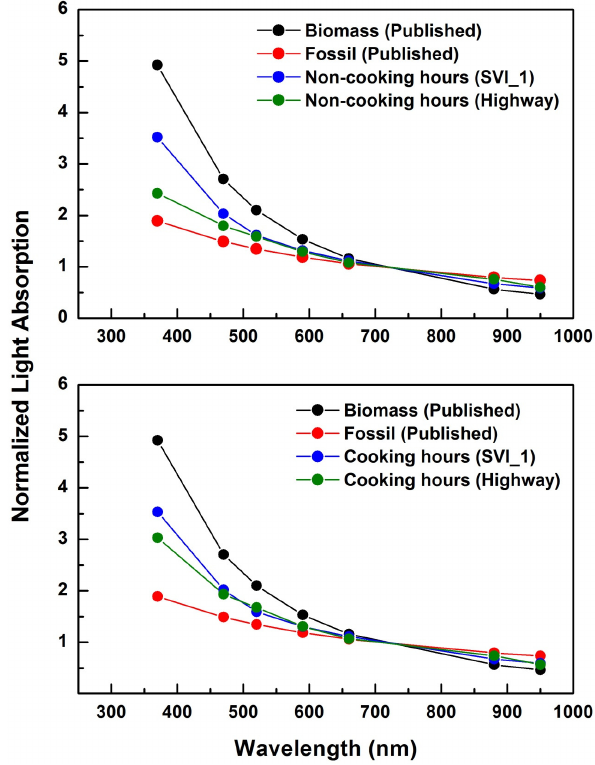
Fig. 6. Comparison of normalized light absorption in aerosol samples collected during cooking and non-cooking hours at Surya village (SVI 1) center and highway, with the previous published (Kirchstetter et al., 2004)